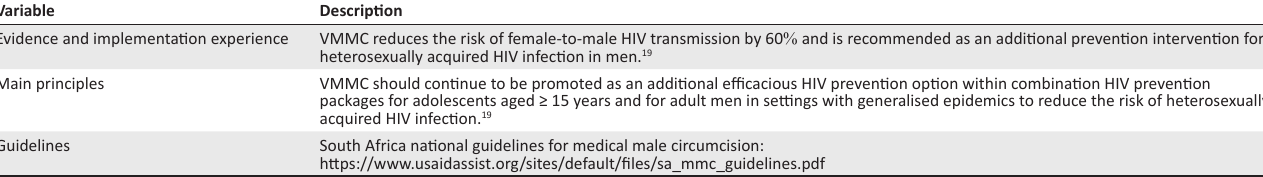
TABLE 14: HIV prevention – voluntary medical male circumcision. 19 Variable Description